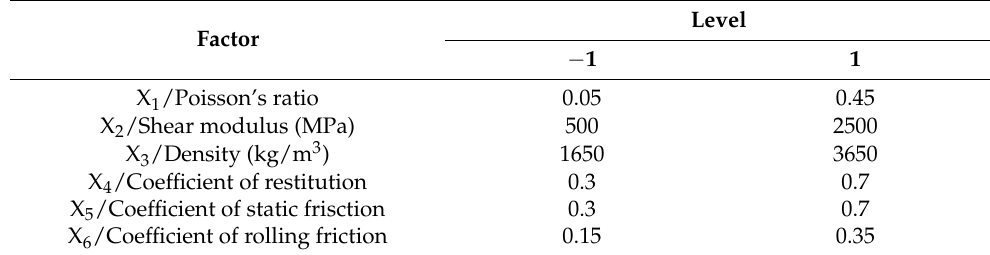
Table 3. Factors and Levels of simulation test.